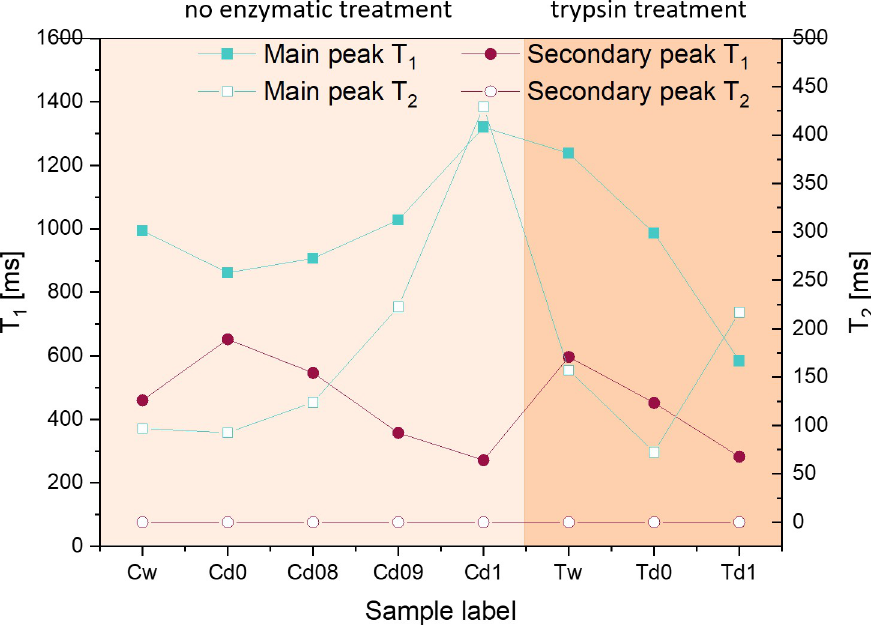
Fig 9. Values of the 1 H T 1 and T 2 relaxation times for both peaks, for all sets of samples. Data averaged over the sets of three samples for each treatment, where available. The left Y axis represents the T 1 values, the right Y axis represents the T 2 values. The values of the secondary peak T 2 remain between 20 and 40 μ